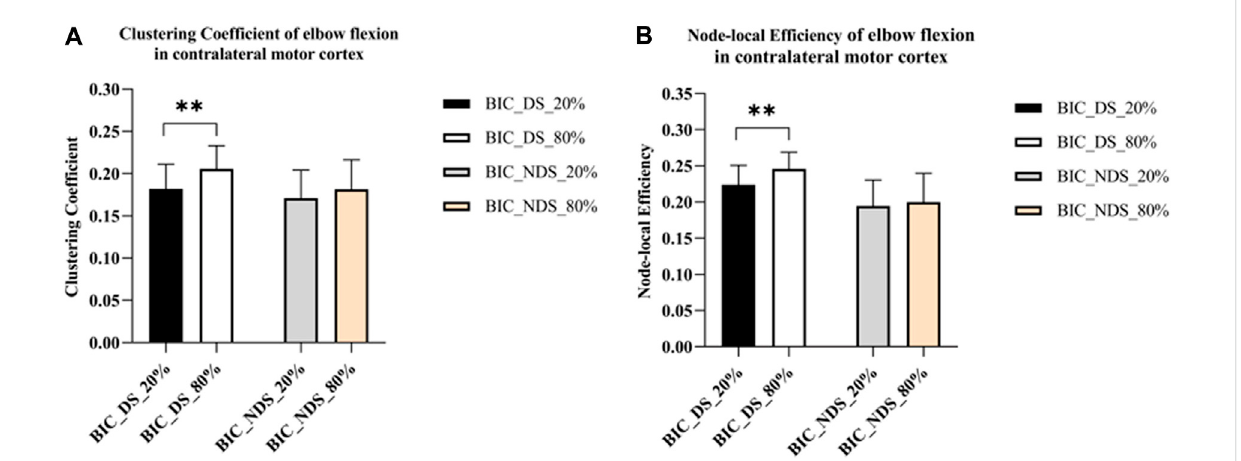
FIGURE 5 Signi fi cant global and local metric changes of elbow fl exion in the contralateral motor cortex. (A) Global metrics results of the clustering coef fi cient ( Δ HbO